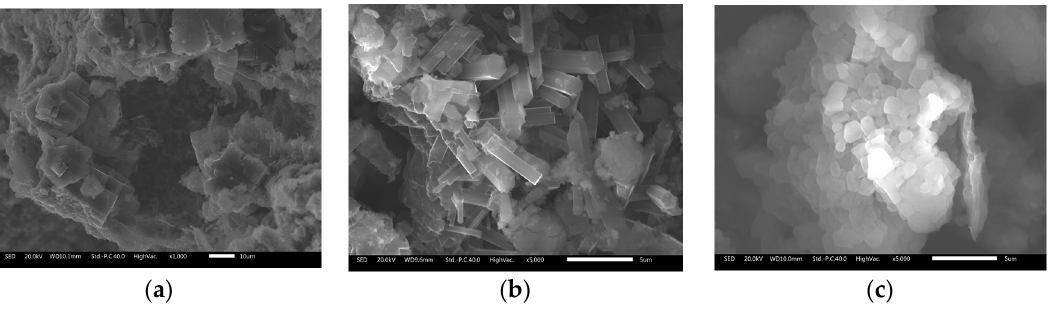
Figure 5. SEM images of the dehydrogenated (DHH) materials: ( a ) 2LiBH 4 + Al-DHH 5 bar, 400 °C; ( b ) 2LiBH 4 + Al/TiF 3 -DHH 5 bar, 400 °C; ( c ) 2LiBH 4 + Al/CeO 2 -DHH 5 bar, 400 °C.